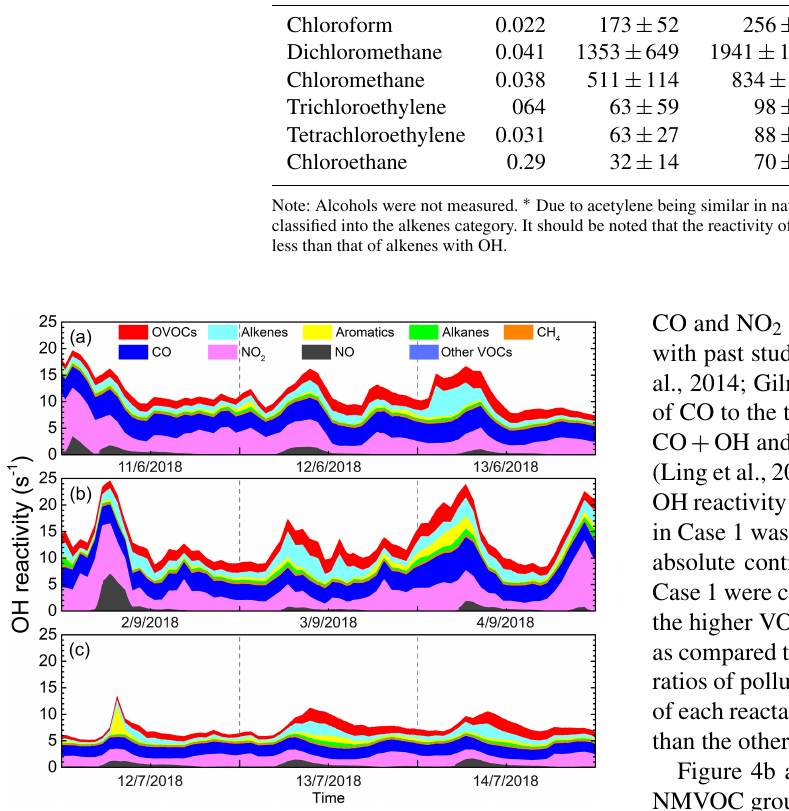
Figure 3. Diurnal profiles of OH reactivity by oxidation of all mea- sured reactant groups at an urban site of Shanghai during (a) Case 1, (b) Case 2 and (c) Case